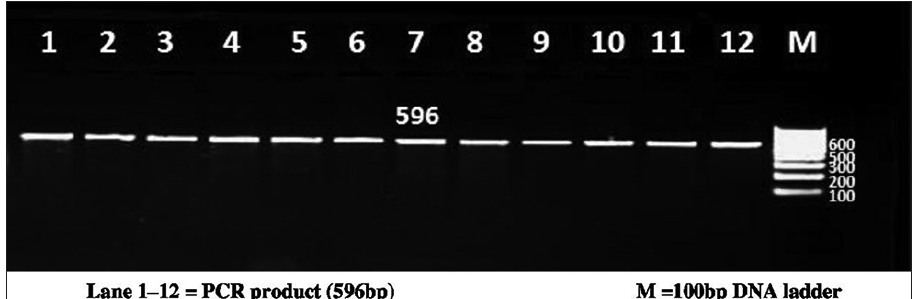
Figure-2: Resolution of polymerase chain reaction (PCR) amplified product of Primer 1 on 2% agarose gel. Lane 1-12=PCR product (596 bp), M=100 bp DNA ladder.